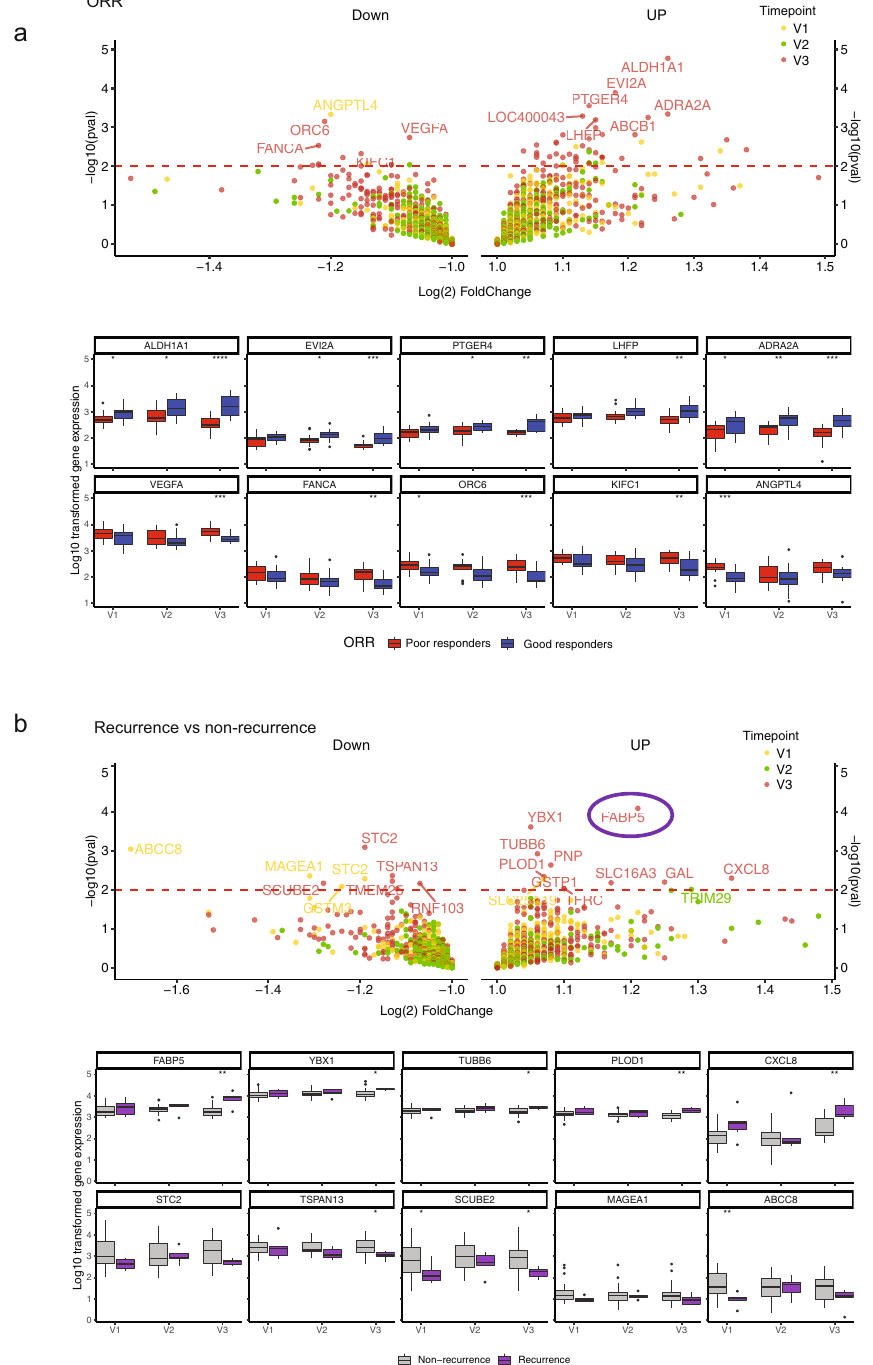
Fig. 3 Gene expression pro fi ling in longitudinal primary breast tumour biopsies. a ORR at surgery (V3) (patients with good response to eribulin vs. poor response) (Top). Genes identi fi ed have a change corresponding to eribulin treatment. Volcano plots with the strength of the association on the y -axis ( − log10 p values) and the effect size on the x -axis (log 2-fold change (FC)). Differentially expressed genes were highlighted during different timepoints across neoadjuvant therapy (V1 – V3). Genes above the red dotted line represent those whose expression levels were signi fi cantly different ( p value < 0.01). A full list of the most up and downregulated genes can be found on Supplementary Data. Boxplots of good and poor responders on eribulin over time, colour-coded by their corresponding poor response (red) or good response (blue) in eribulin from baseline to surgery (Bottom). b Same as in ( a ). Patients with later clinical recurrence vs. no recurrence (Top). Boxplots of individual patients on eribulin over time, colour-coded by their corresponding recurrence (purple) or nonrecurrence (grey) in eribulin from baseline to surgery